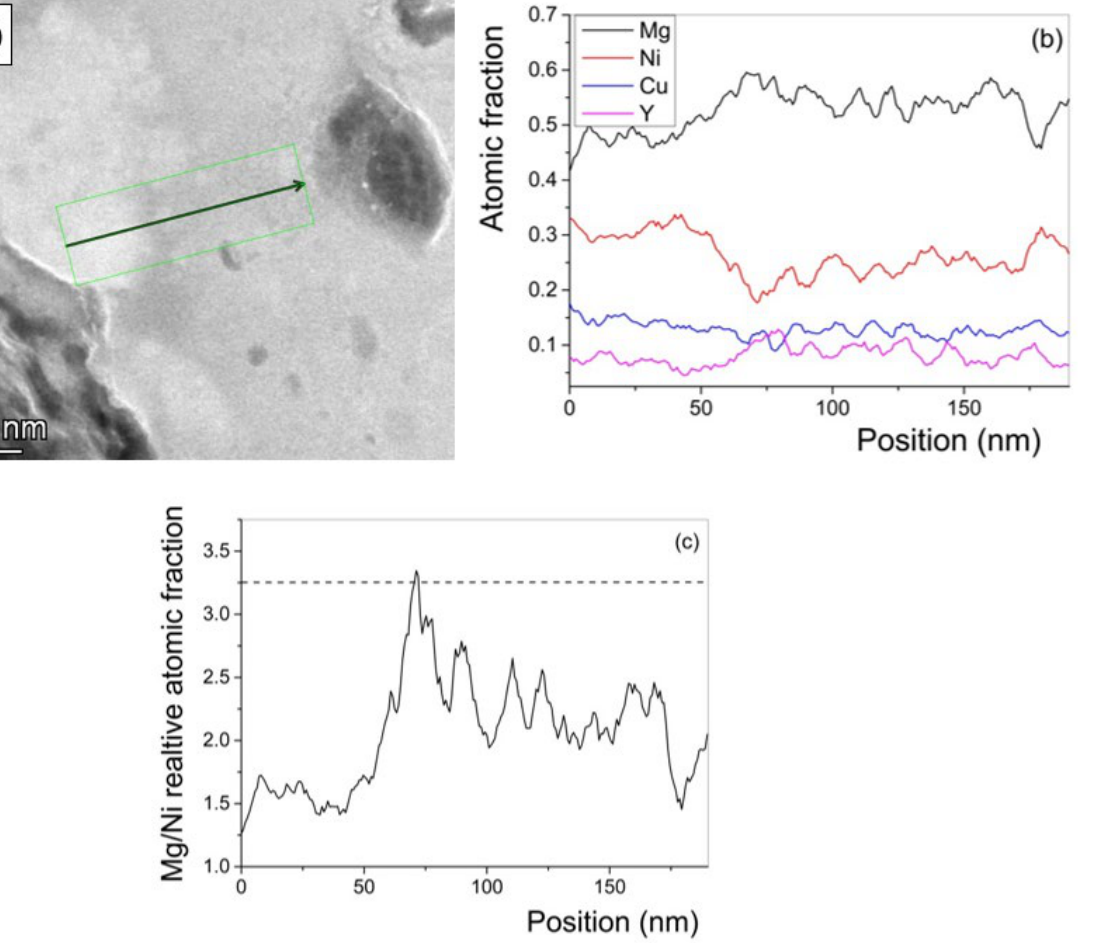
Figure 9. ( a ) HAADF image of the MgNiCuY_CNT_5 disk. The arrow indicates an EDS line measurement. ( b ) Atomic fractions of the constituting elements along the line marked in ( a ). ( c ) Relative atomic fractions of Mg and Ni along the line marked in ( a ); the dashed line indicates the nominal composition.